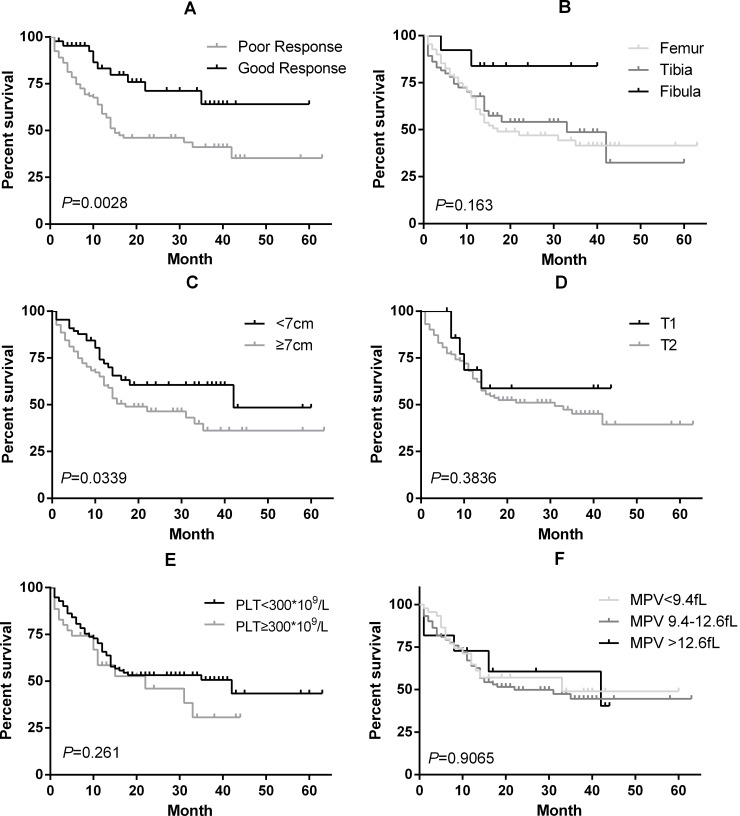
Kaplan-Meier curves for DFS according to the response to neo-adjuvant chemotherapy (A), tumor site (B), tumor size (C), T stage (D), PLT (E), and MPV (F).